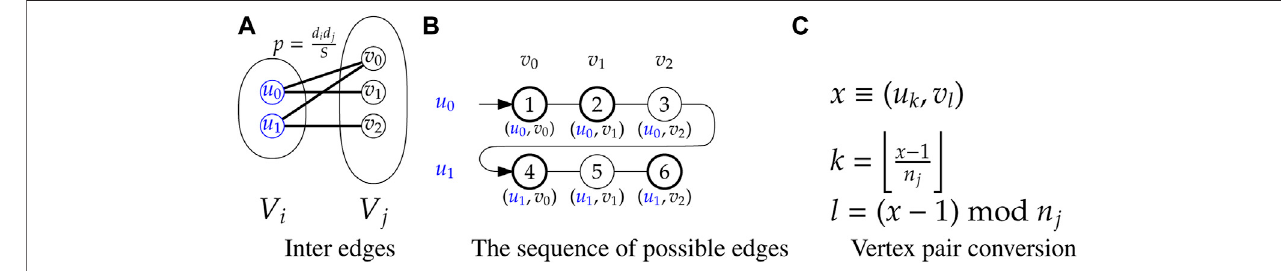
) (cid:1) Λ ( Λ − 1 ) inter edge groups 2 2